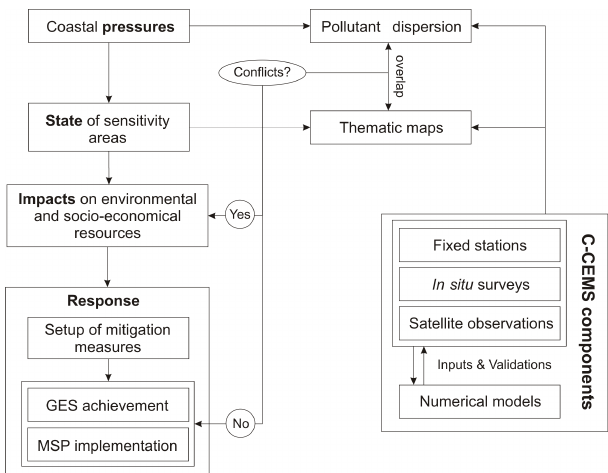
Figure 2. The role of C-CEMS in the analysis of the conflicts be- tween coastal pressures, in terms of pollutant dispersion, and sensi- tivity areas, represented by thematic maps. This observing system includes different components such as fixed stations, in situ surveys, satellite observations and numerical models. The components inter- act between them to transfer data (by input I and validation V) from the in situ and satellite observations to numerical models in order to reach enough temporal and spatial resolution to analyze the pollu- tant dispersion in coastal waters. Only if conflicts between anthropic activity and sensitivity areas occur are the potential impacts on en- vironment and socio-economical resources analyzed (Impacts) and suitable mitigation measures applied (Response) in order to achieve Good Environmental Status (GES) and implement Marine Spatial Planning Directive